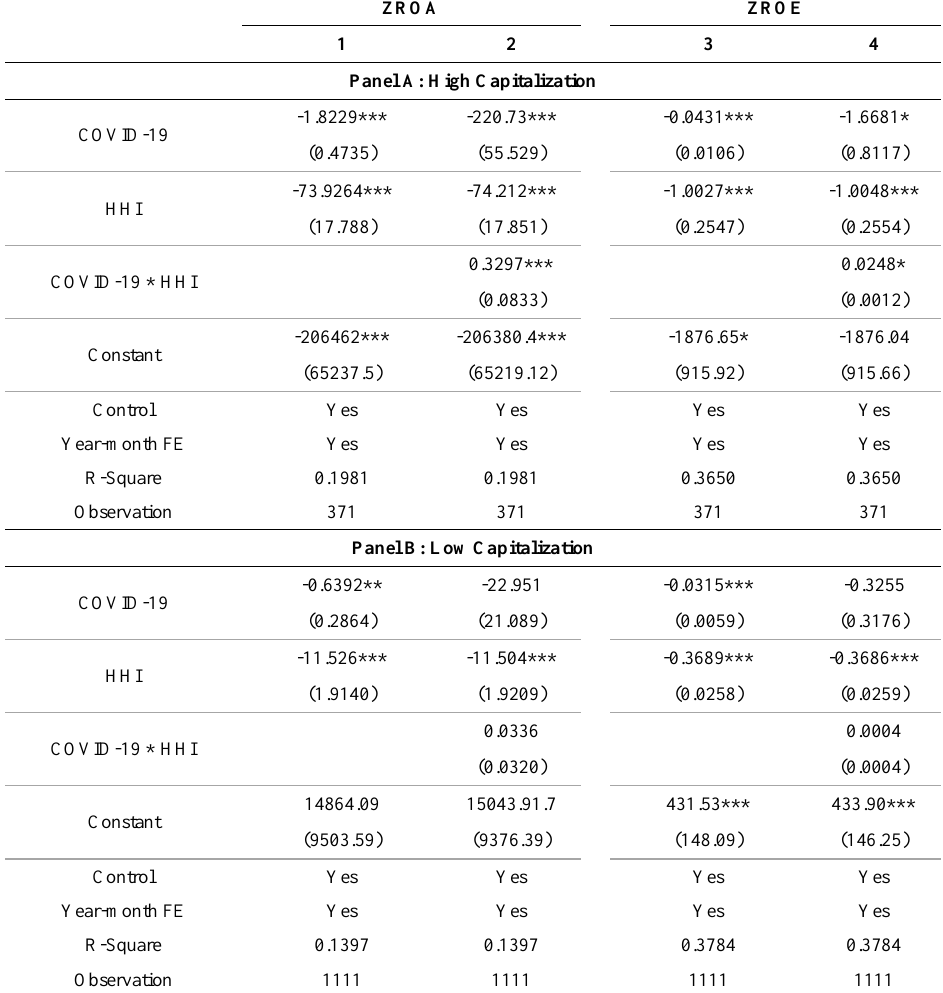
Table 4. The Impact of COVID-19 and Bank Concentration on Bank Stability for High and Low Capitalization ZROA ZROE